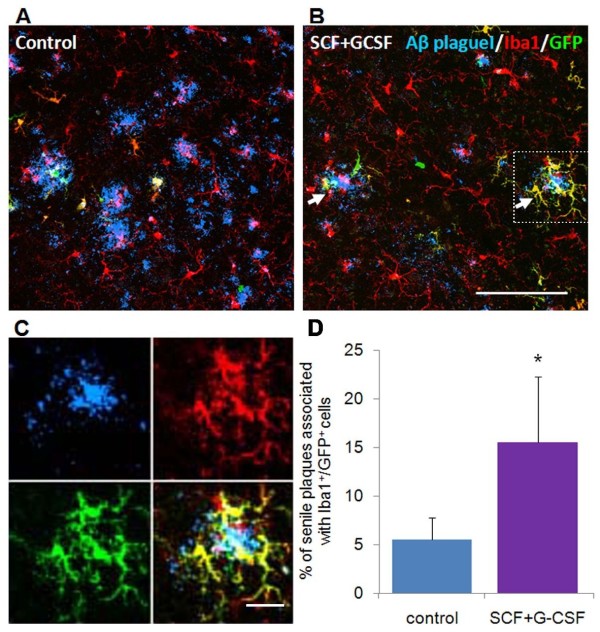
Association between bone marrow-derived microglia and β-amyloid plaques in the brains of APP/PS1 mice. (a), (b) Immunohistochemical identification of bone marrow-derived microglia and β-amyloid (Aβ) plaques. Bone marrow-derived cells are the cells expressing green fluorescent protein (GFP) (green). Microglia are identified with an anti-Iba1 antibody (red). Yellow cells are the bone marrow-derived microglia that are co-labeled with GFP and Iba1. β-amyloid deposition is determined with an anti-β-amyloid antibody (clone 4G8) (blue). The white arrows indicate β-amyloid deposits surrounded by bone marrow-derived microglial cells (yellow). (c) High-magnification confocal images of the image indicated with dashed lines in (b). (d) Quantification of the bone marrow-derived microglia associated with β-amyloid plaques in the brain. Data presented as mean ± standard error. *P < 0.05. Scale bar: (b) 100 μm (for both images in (a) and (b)); (c) 25 μm. G-CSF, granulocyte colony-stimulating factor; SCF, stem cell factor.